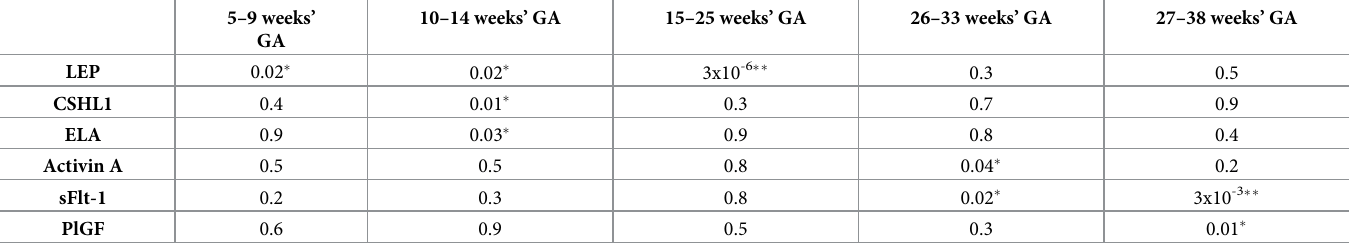
Table 2. Comparisons of the serum levels of each protein between normal and PE pregnancies. Mann-Whitney U-test P -value was calculated. � 0.005 < P < 0.05. �� P <